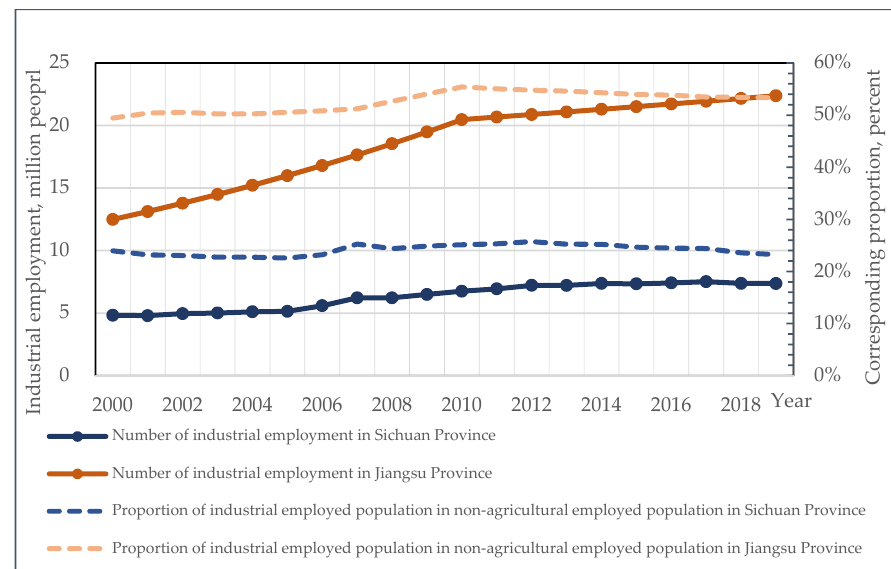
Figure 4. Comparison of industrial employment in Sichuan and Jiangsu from 2000 to 2019 (data sources are Sichuan Statistical Yearbook 2020 and Jiangsu Statistical Yearbook 2020 ).